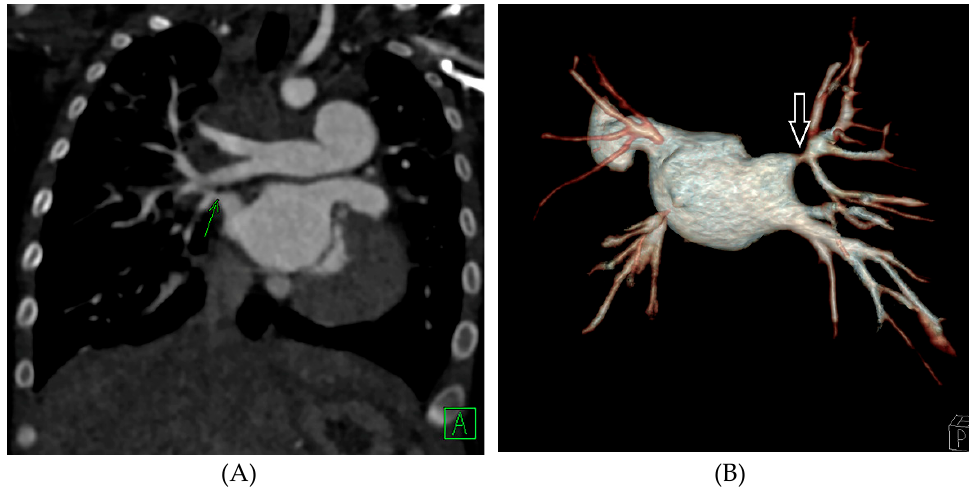
Figure 1. ( A ): Coronal slice of a CT angiogram demonstrates right upper pulmonary vein stenosis (green arrow). ( B ): Posterior view of the three-dimensional reconstruction of the CT angiogram of the same patient also demonstrates right upper pulmonary vein stenosis (white arrow), in addition to severe stenosis of the left lower pulmonary vein and atresia of the left upper pulmonary vein.